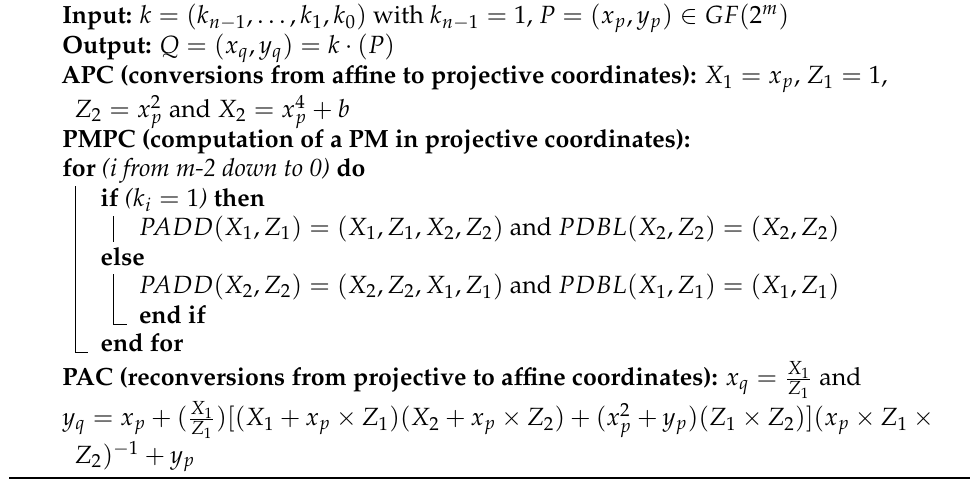
Algorithm 1: Montgomery PM Algorithm